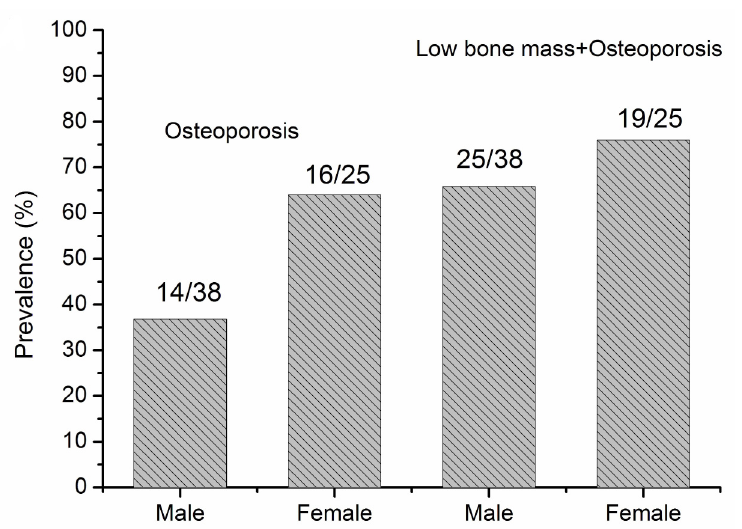
Figure 3. The prevalence of osteoporosis and bone loss (low bone mass + osteoporosis) in old patients (>50 years) with pancreatic neuroendocrine tumors (PNETs).